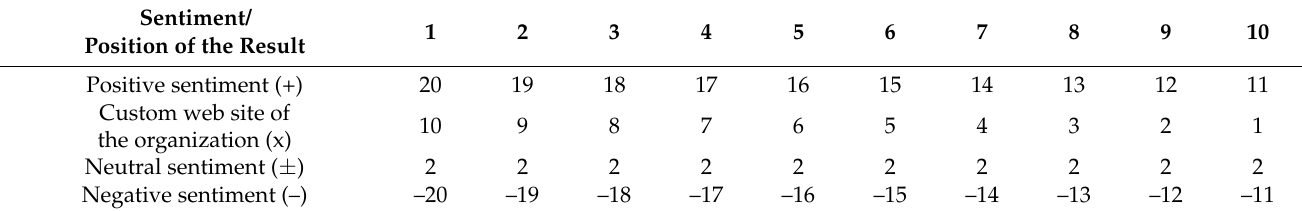
namely: (i) positive sentiment, (ii) the entity’s own website, (iii) neutral sentiment, and (iv) negative sentiment. In terms of ranking, the first 10 positions in the Google search result were considered. Table 1 presents the key for quantification of the measured varia- bles: Table 1. Sentiment analysis quantification table (Poll á k et al. Table 1. Sentiment analysis quantification table (Pollák et al. 2021b).